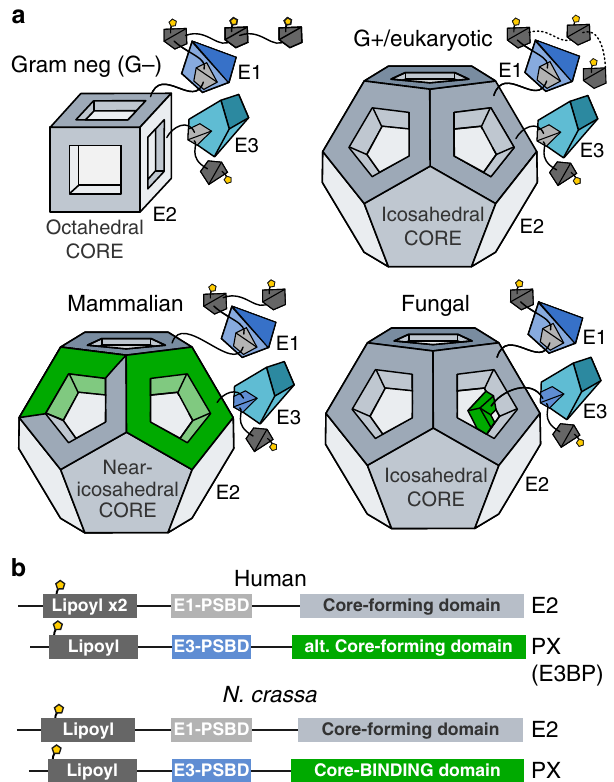
Fig. 4 The fungal PDC is analogous in function to the mammalian PDC, but structurally distinct. a Previously known PDC assemblies are octahedral and icosahedral core assemblies surrounded by fl exibly tethered enzymes. The mammalian PDC has been shown to include an alternate core-forming protein that speci fi cally recruits E3, but where an unknown mechanism and/or arrangement supplies a stoichiometric regulation to 40:20 or 48:12. The fungal PDC appears to also recruit E3 separately, but through a mechanism that maintains a homomeric core with strict icosahedral symmetry. The additional protein in the case of N. crassa forms a tetrahedral assembly interior to the core under optimal conditions, which results in a binding stoichiometry in direct correspondence to the icosahedral and tetrahedral symmetries, i.e., 60:12. The fungal PDC thus appears to have arrived at a similar stoichiometry and functional equivalence as the mammalian PDC, through an entirely distinct structural mechanism. b The domain topology and function of mammalian and fungal PX are strikingly similar, despite their disparate structural